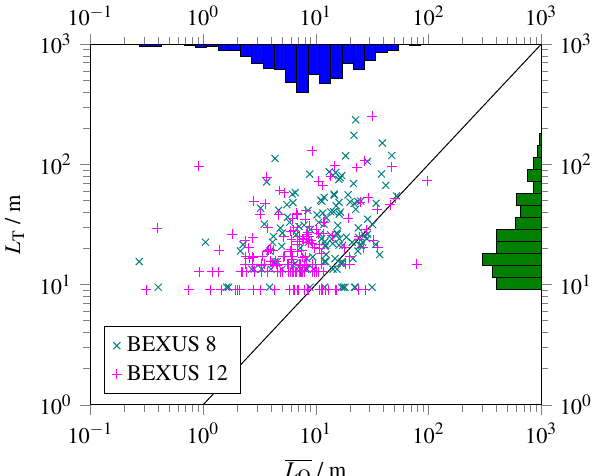
Figure 5. Thorpe scale L T vs. Ozmidov scale L O for the BEXUS 8 (green) and 12 (magenta) flights. The black diagonal line represents L O = L T . The histograms show the distributions of L O and L T , respectively, of the composite data set of BEXUS 8 and BEXUS 12, i.e. of all data points in the graph. The occurrence axes have a linear scale and are omitted for readability. Note that L T is limited by the resolution of the radiosonde ( ∼ 10m).